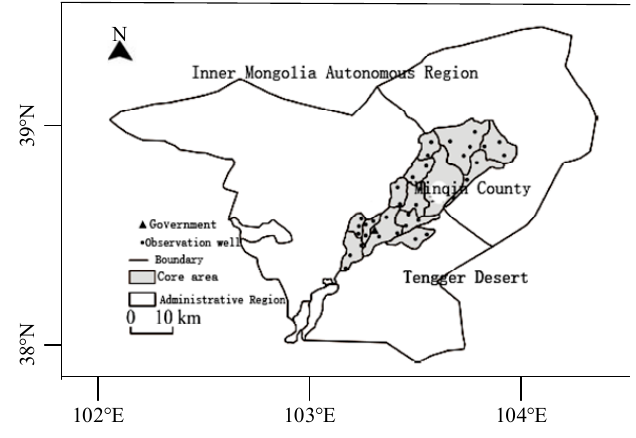
Figure 1. Geographical location of the study area.